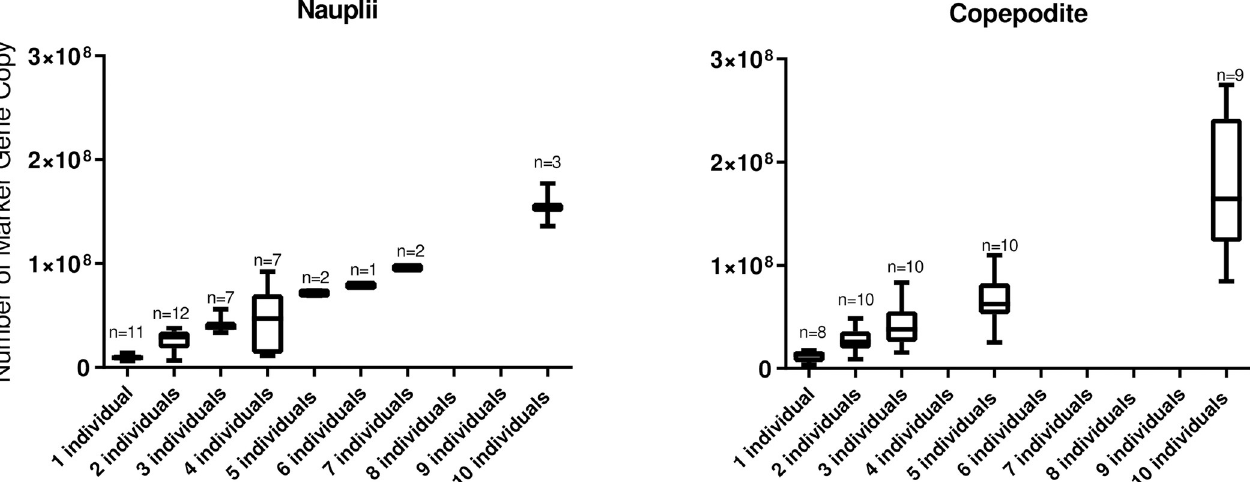
Fig 2. SL2 qPCR assay and number of individuals. Boxplot of the relationship between the number of MGC (Marker Gene Copy) and the number of nauplii and copepodite individuals per sample, n = number of samples analyzed.